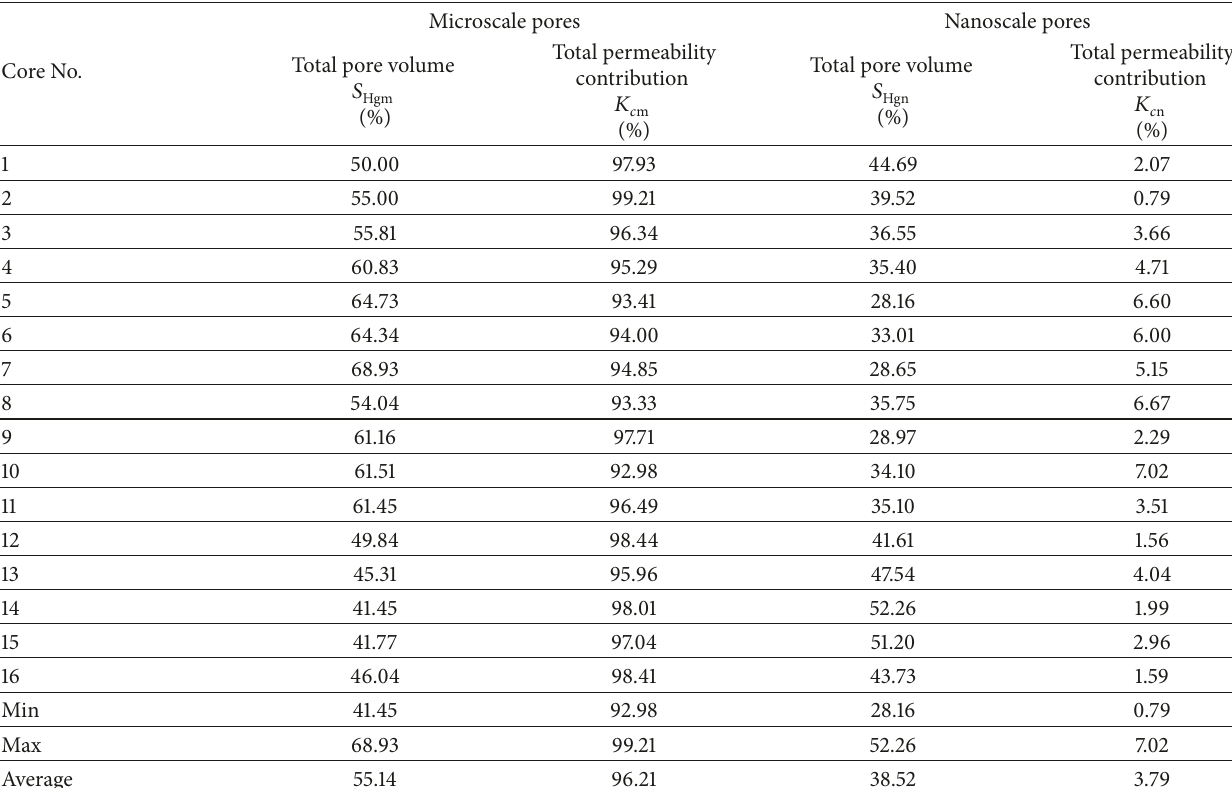
Table 5: The total pore volume and permeability contribution of microscale pores and nanoscale pores.